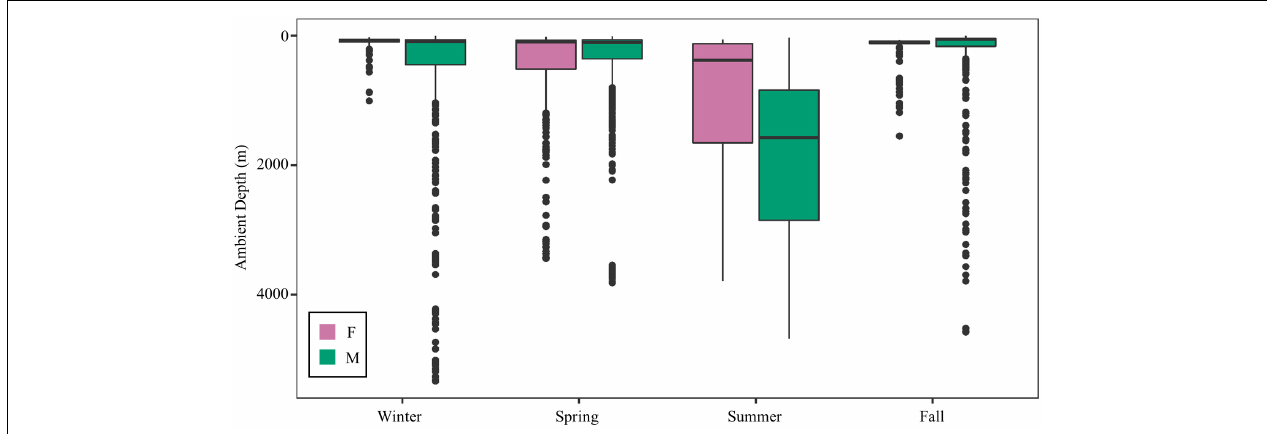
FIGURE 8 | Seasonal ambient water depth (m) by sex. Males frequented a wider range of ambient depths except during the spring, which was the only season when both sexes were located in the Gulf of Mexico during the entire